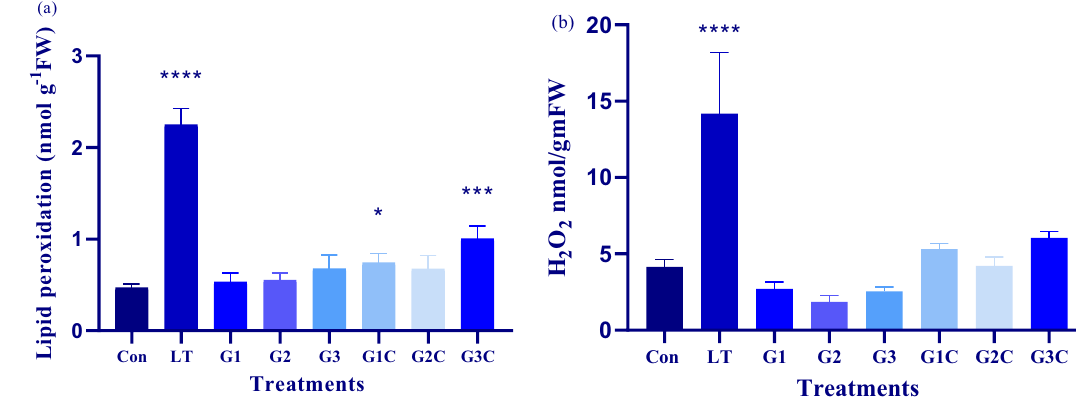
Figure 6. Effect of LT stress and GSH on oxidative stress parameters: Forty days after sowing seedlings were used for experimentation pertaining to LT stress and exogenously applied GSH. Post 3 days recovery determination of ( a ) lipid peroxidation ( b ) hydrogen peroxide content was carried. The data depicts the mean and standard deviation of three replicates. Data followed by (*) determines level of significance (p < 0.05) as predicted by Dunnet’s multiple comparison test. Control (Con): 25/18 °C + 0 mM GSH, Low temperature stress (LT): 10/3 °C + 0 mM GSH , G1: 25/18 °C + 0.5 mM GSH , G2: 25/18 °C + 1 mM GSH, G3: 25/18 °C + 2 mM